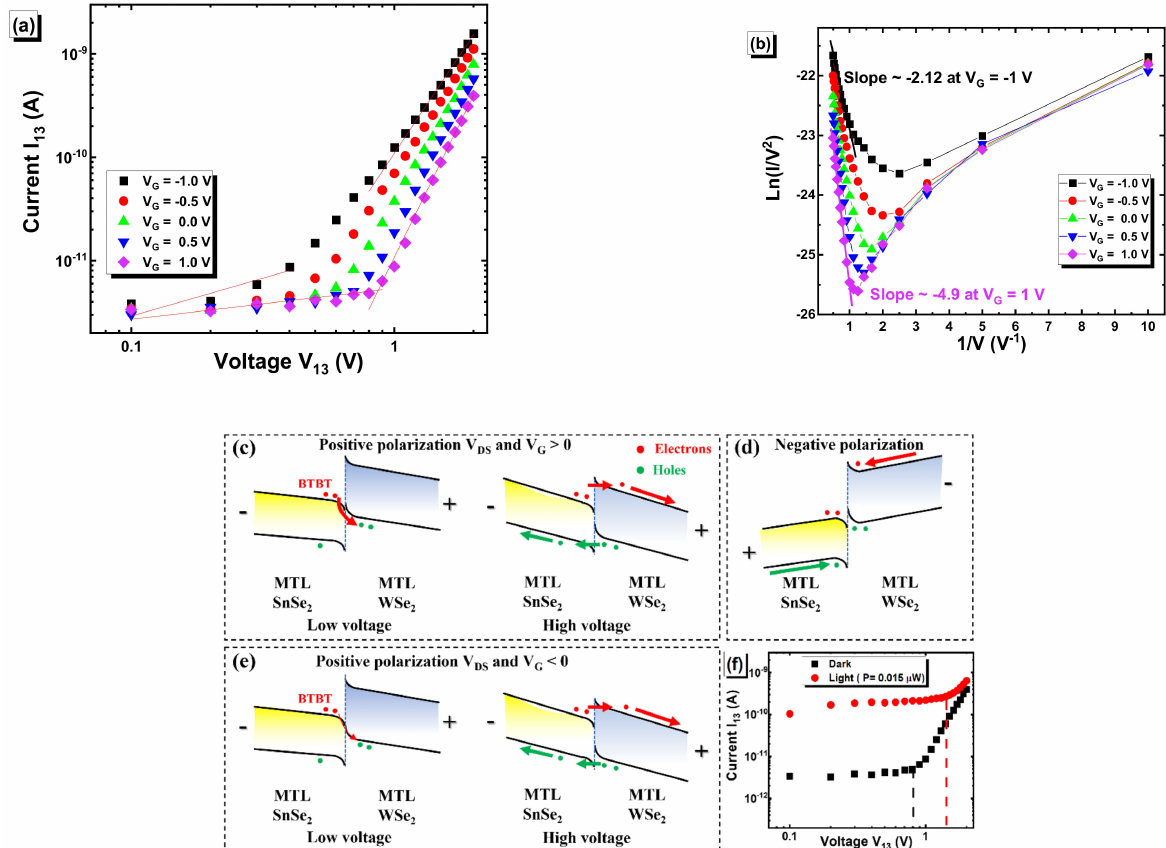
Figure 6. ( a ) Log current scale in the forward region and its corresponding ( b ) ln (I/V 2 )–1/V curve, energy band diagrams of p-WSe 2 /n-SnSe 2 heterostructure, ( c ) (V DS > 0 and V G > 0), ( d ) (V DS < 0 and V G > 0), ( e ) (V DS > 0 and V G < 0), and ( f ) I–V curves of p-WSe 2 /n-SnSe 2 heterostructure in dark and under light